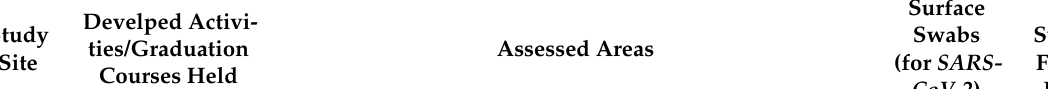
Table 1. Developed activities, areas sampled and samples number in each